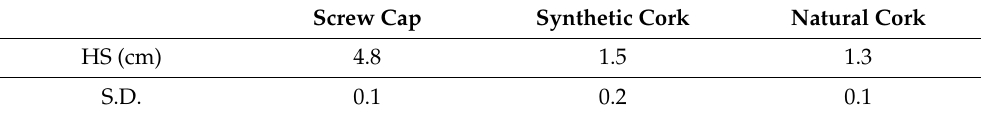
Table 4. Average headspace measurements in cm and standard deviation for each closure type ( n =